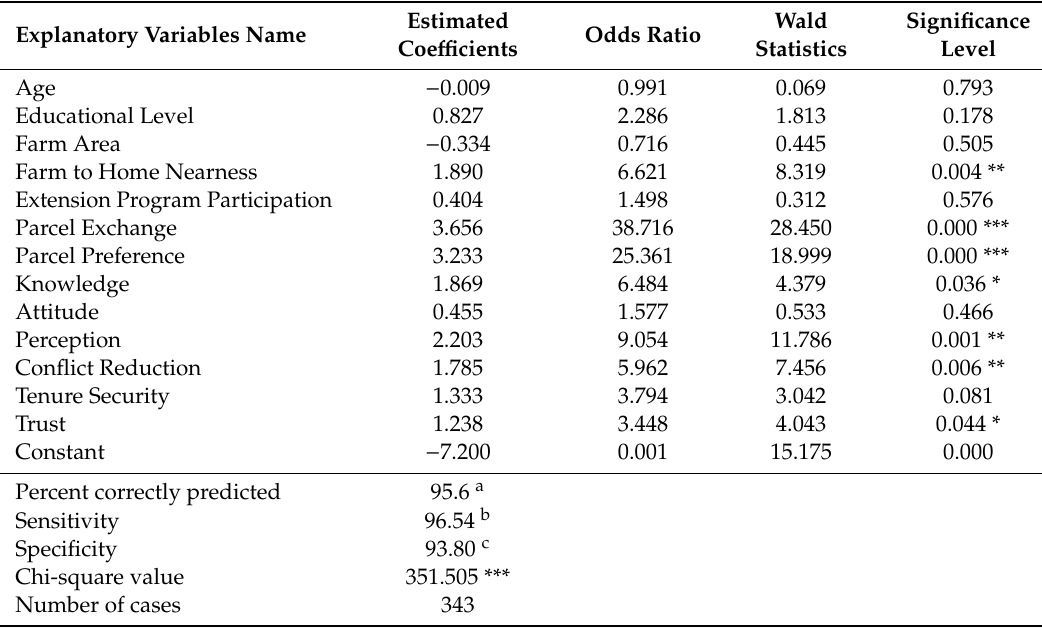
Table 5. Results of the logistic regression